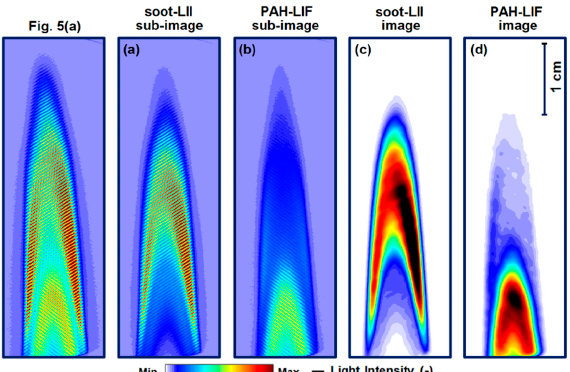
Figure A1. Averaged sub-image of symmetric flame containing modulated signals of both PAH-LII given in Figure 5a. In ( a , b ), the unprocessed averaged sub-images (300 single-shots, central plane) of only soot-LII signal and only PAH-LIF are given, respectively. Therefore, only one species is excited at a time and not simultaneously. In ( c , d ), the processed soot-LII and PAH-LIF corresponding to ( a , b ), respectively, are given.